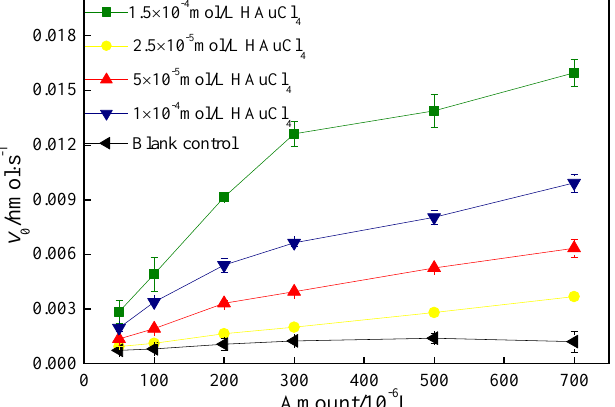
Figure 6. E ff ect of the amount of pMMO–AuNP nanobiohybrids on the rate of hydroquinone Figure 6. Effect of the amount of pMMO–AuNP nanobiohybrids on the rate of hydroquinone oxidation.